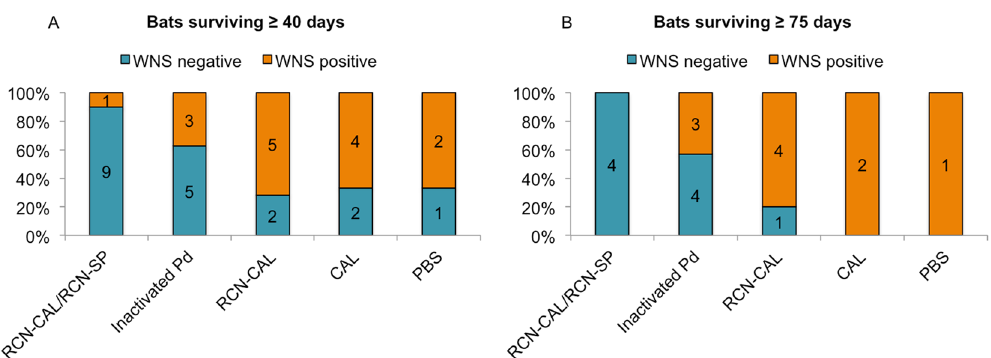
Figure 2. Proportion of Myotis lucifugus positive and negative for white-nose syndrome (WNS) by histological examination after challenge with Pseudogymnoascus destructans (Pd ) in hibernating bats surviving 40 days or more ( A ) or 75 days or more ( B ). Bats received either a combination of raccoon poxvirus (RCN) expressing calnexin (CAL) and RCN expressing serine protease (RCN-CAL/RCN-SP), inactivated Pd , RCN-CAL only, purified CAL protein, or phosphate buffered saline (PBS). Numbers indicate the total number of bats in each